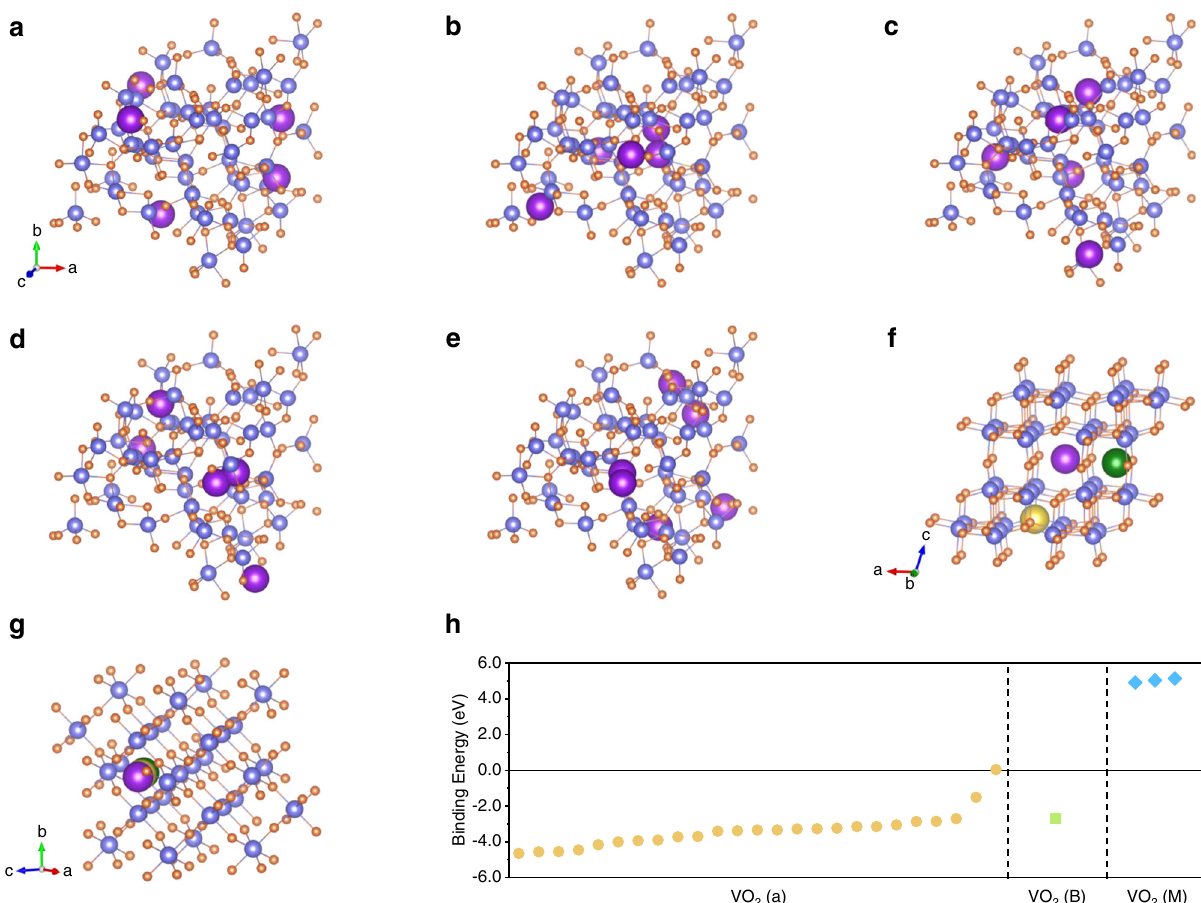
Fig. 2 | Comparison ofthe binding energies ofK + ions for different VO 2 phases. The K + ions insertion sites in ( a – e ) VO 2 (a), ( f ) VO 2 (B),and ( g ) VO 2 (M). h The binding energies of K + ions at different positions in VO 2 (a), VO 2 (B), and VO 2